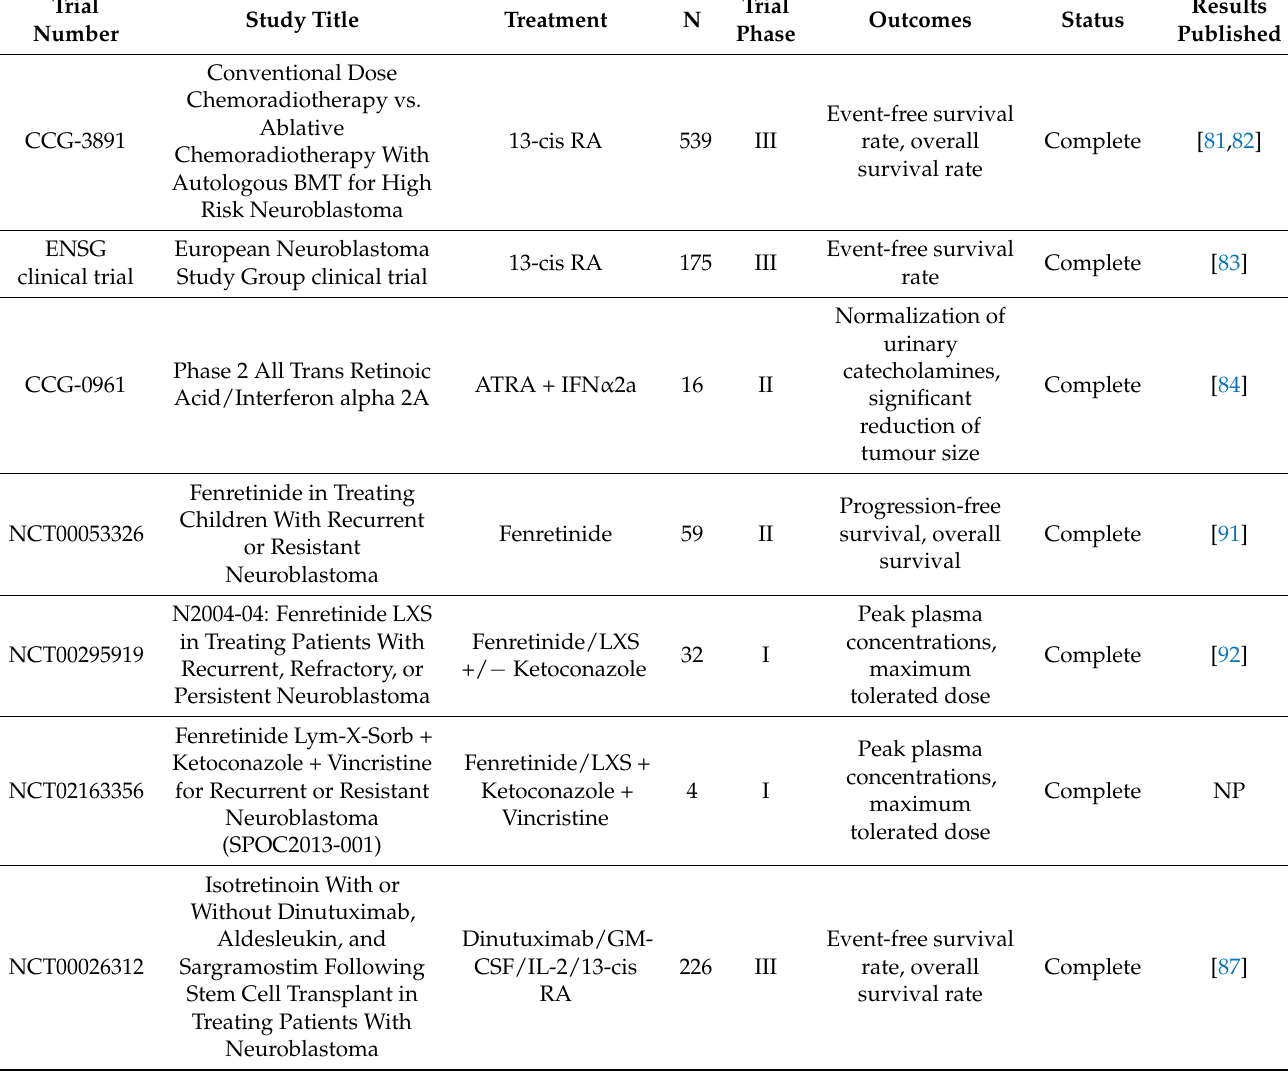
Table 5. Summary of Pivotal Clinical Trials for RA use in